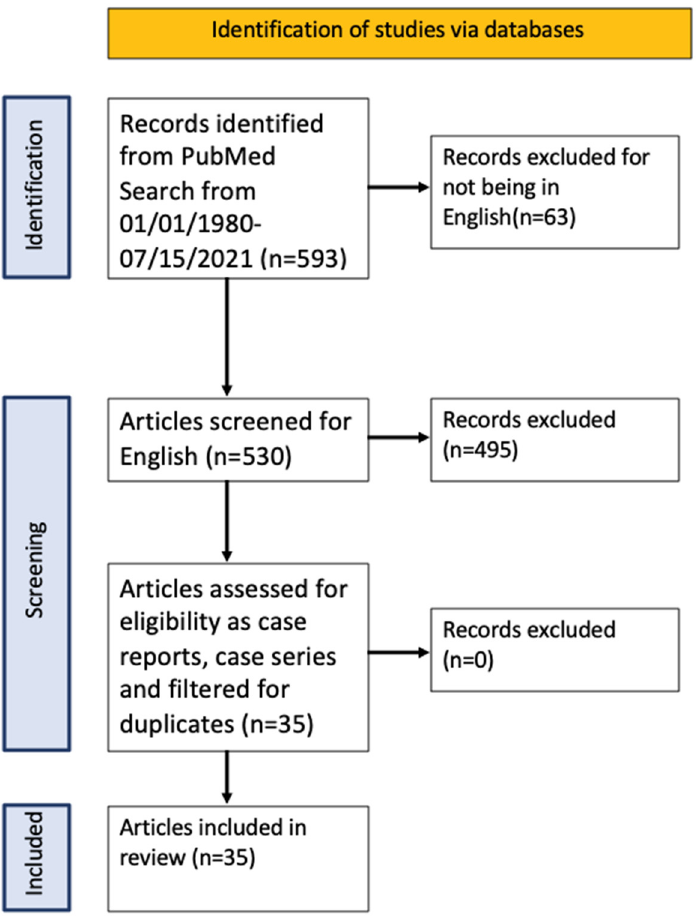
Figure 1. PRISMA table for the literature review.